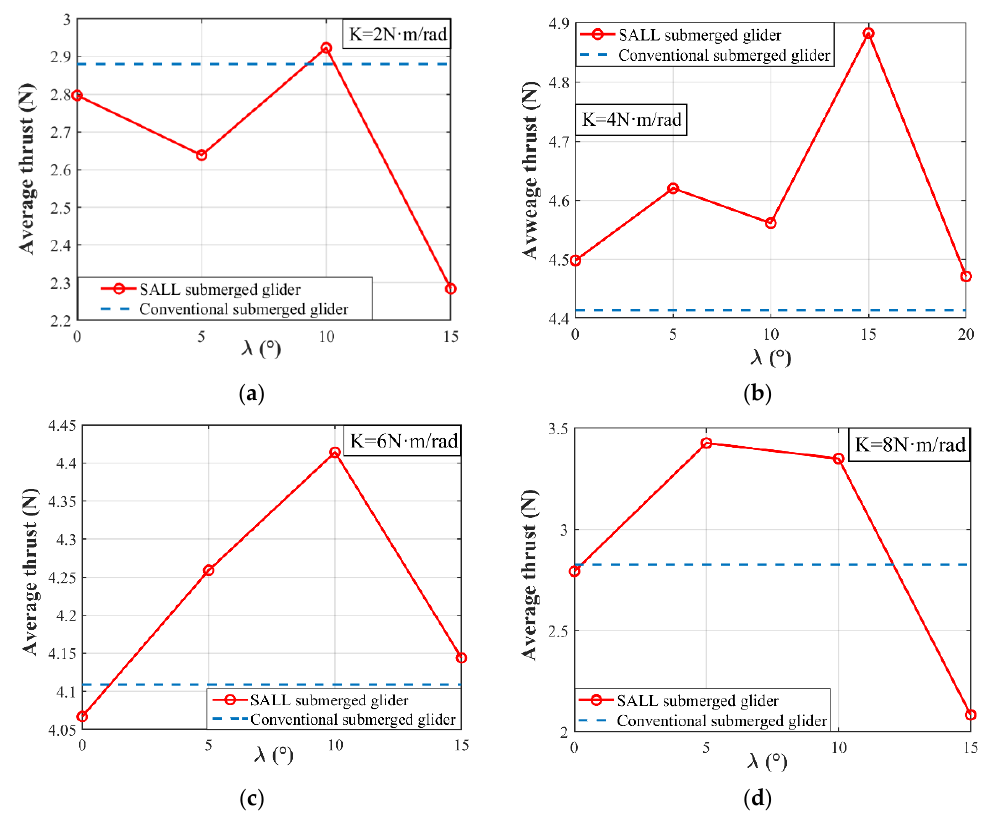
Figure 17. The average thrusts of the SALL submerged glider and the conventional submerged glider under the different K. ( a ) Average forward thrust under k = 2; ( b ) average forward thrust under k = 4; ( c ) average forward thrust under k = 6; and ( d ) average forward thrust under k = 8.